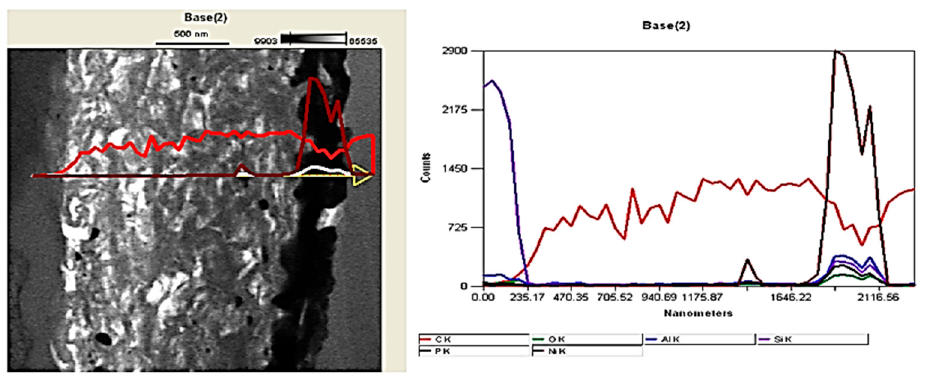
Figure 11. TEM images of the interface between fibre and aluminium alloy matrix of MMC2 sam- ple before the push-out test.